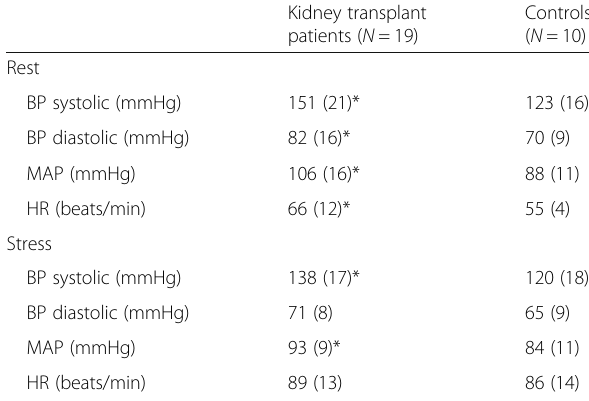
Table 2 Blood pressure and heart rate of the study subjects